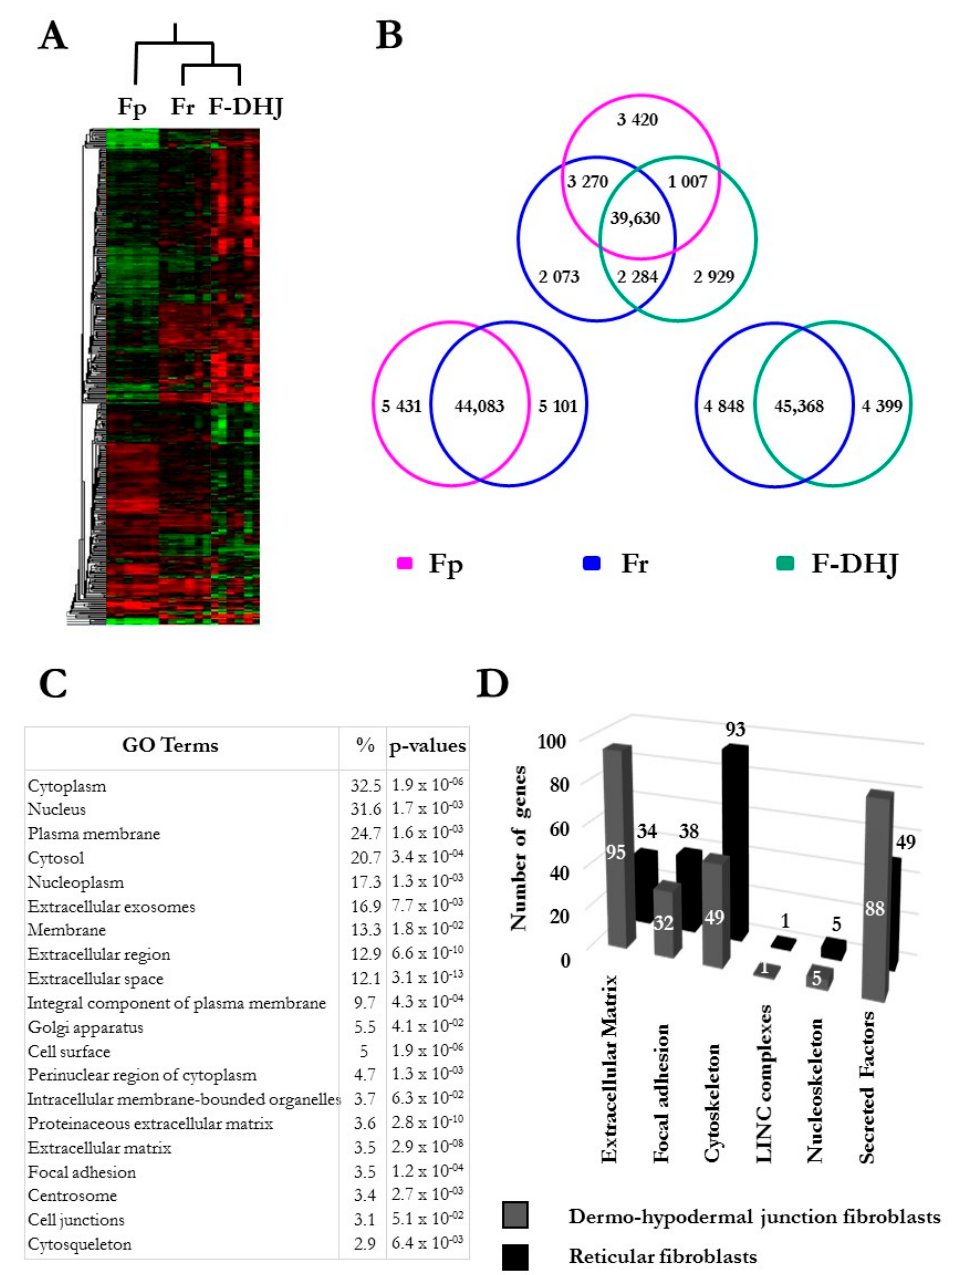
Figure 4. Microarray analysis of the transcriptome profiles of Fp, Fr, and F-DHJ fibroblasts (donors’ ages: 22, 25, 28, 55, 61, and 65 y.o.). ( A ) Hierarchical clustering based on 1078 differentially expressed transcripts (fold-change cutoff at 3 and p < 0.05). ( B ) Venn Diagrams summarizing Fp, Fr, and F-DHJ-enriched transcriptional signatures ( p < 0.05). ( C ) List of the 20 most significant gene ontology (GO) terms differentiating F-DHJ from Fr cells, based on 2540 probe sets (1647 transcripts) exhibiting differential signals (fold-change >1.5 and p < 0.05). ( D ) Signatures identifying Fr fibroblasts (black bars) and F-DHJ fibroblasts (grey bars) among transcripts related to the tissue skeleton biology (fold-change > 1.5 and p < 0.05).